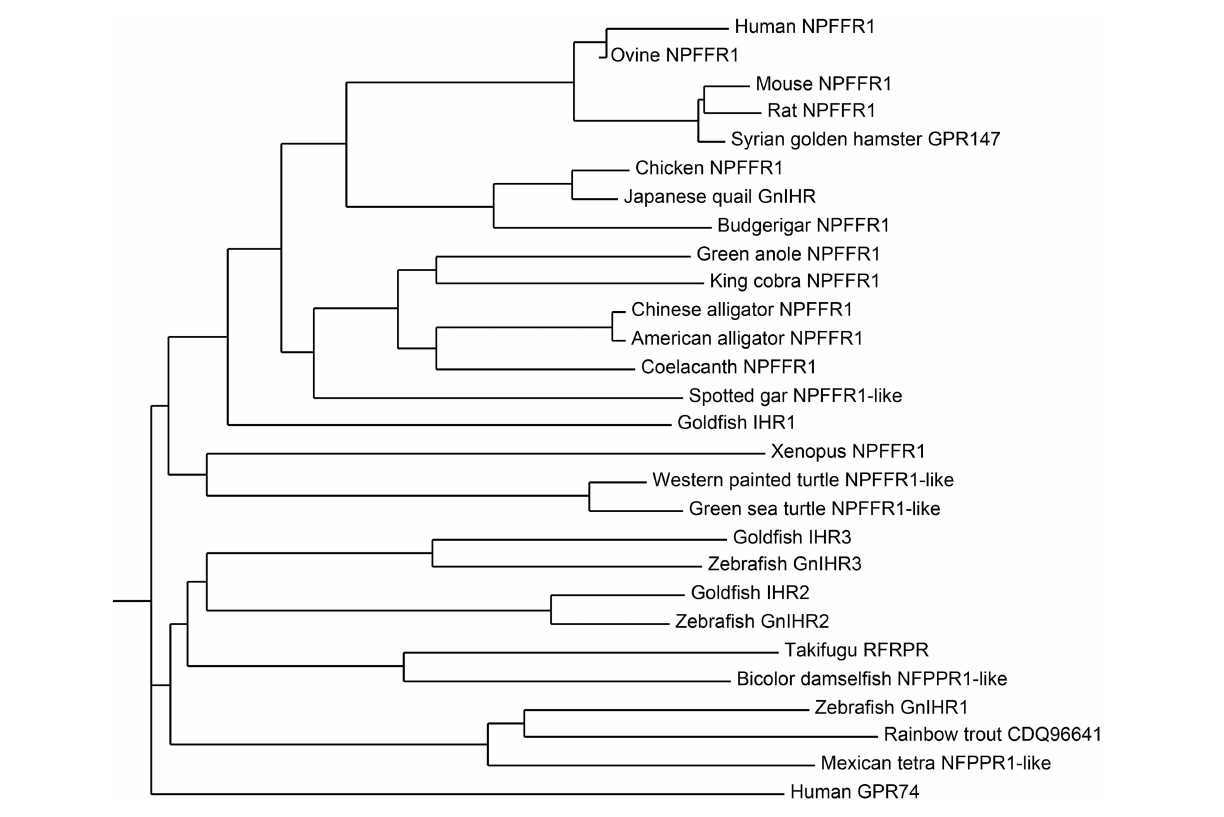
FIGURE 2 | Phylogenetic tree of GnIH receptor (GPR147) and its homologous sequences in vertebrates .The phylogenetic tree was constructed by MEGA 3.1 using the neighbor-joining method. GenBank accession numbers for the sequences are listed in Table 2 .